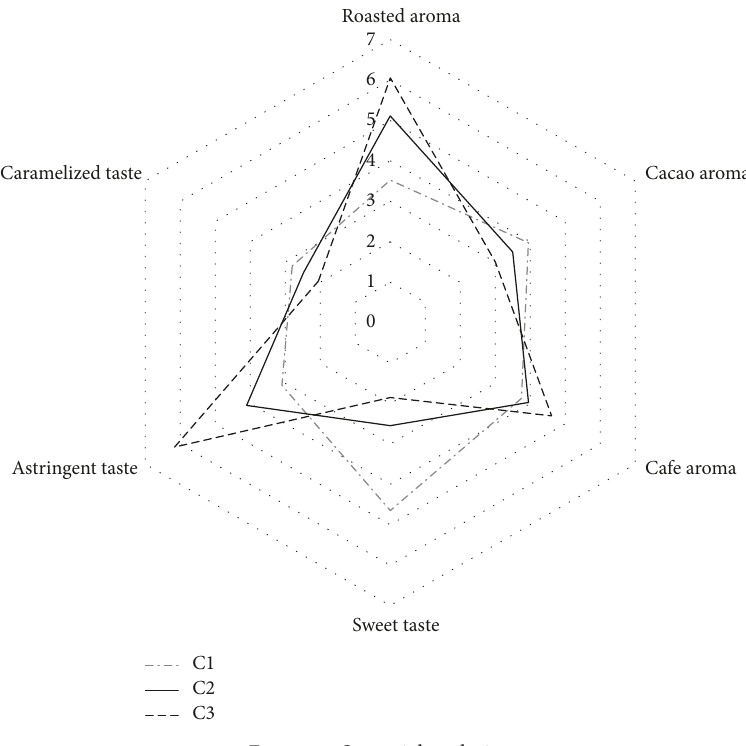
Figure 7: Sensorial